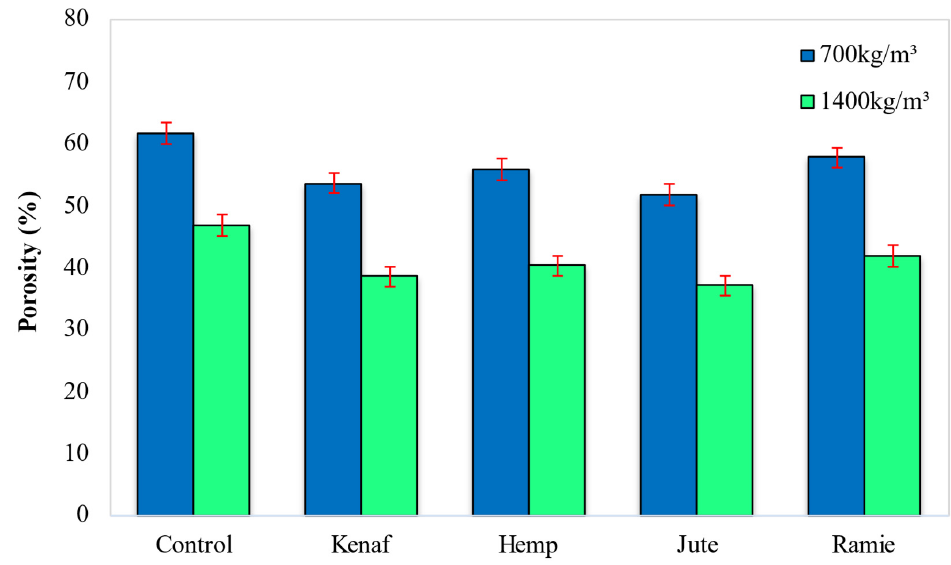
Figure 11. Effect of different types of fiber on porosity of LFC .